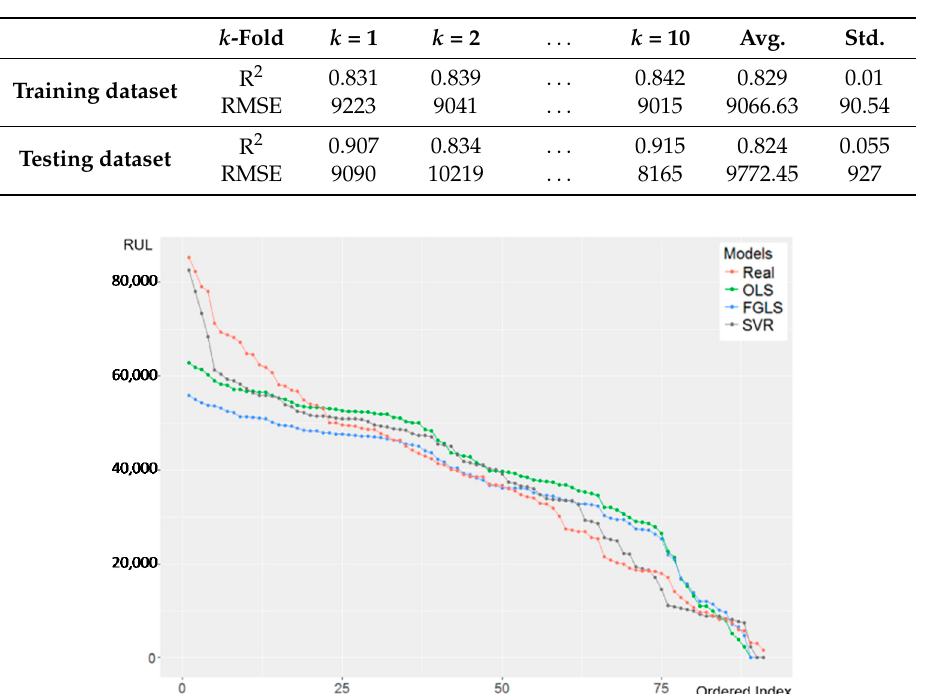
Figure 11. Fitted plot of OLS, FGLS and SVR.